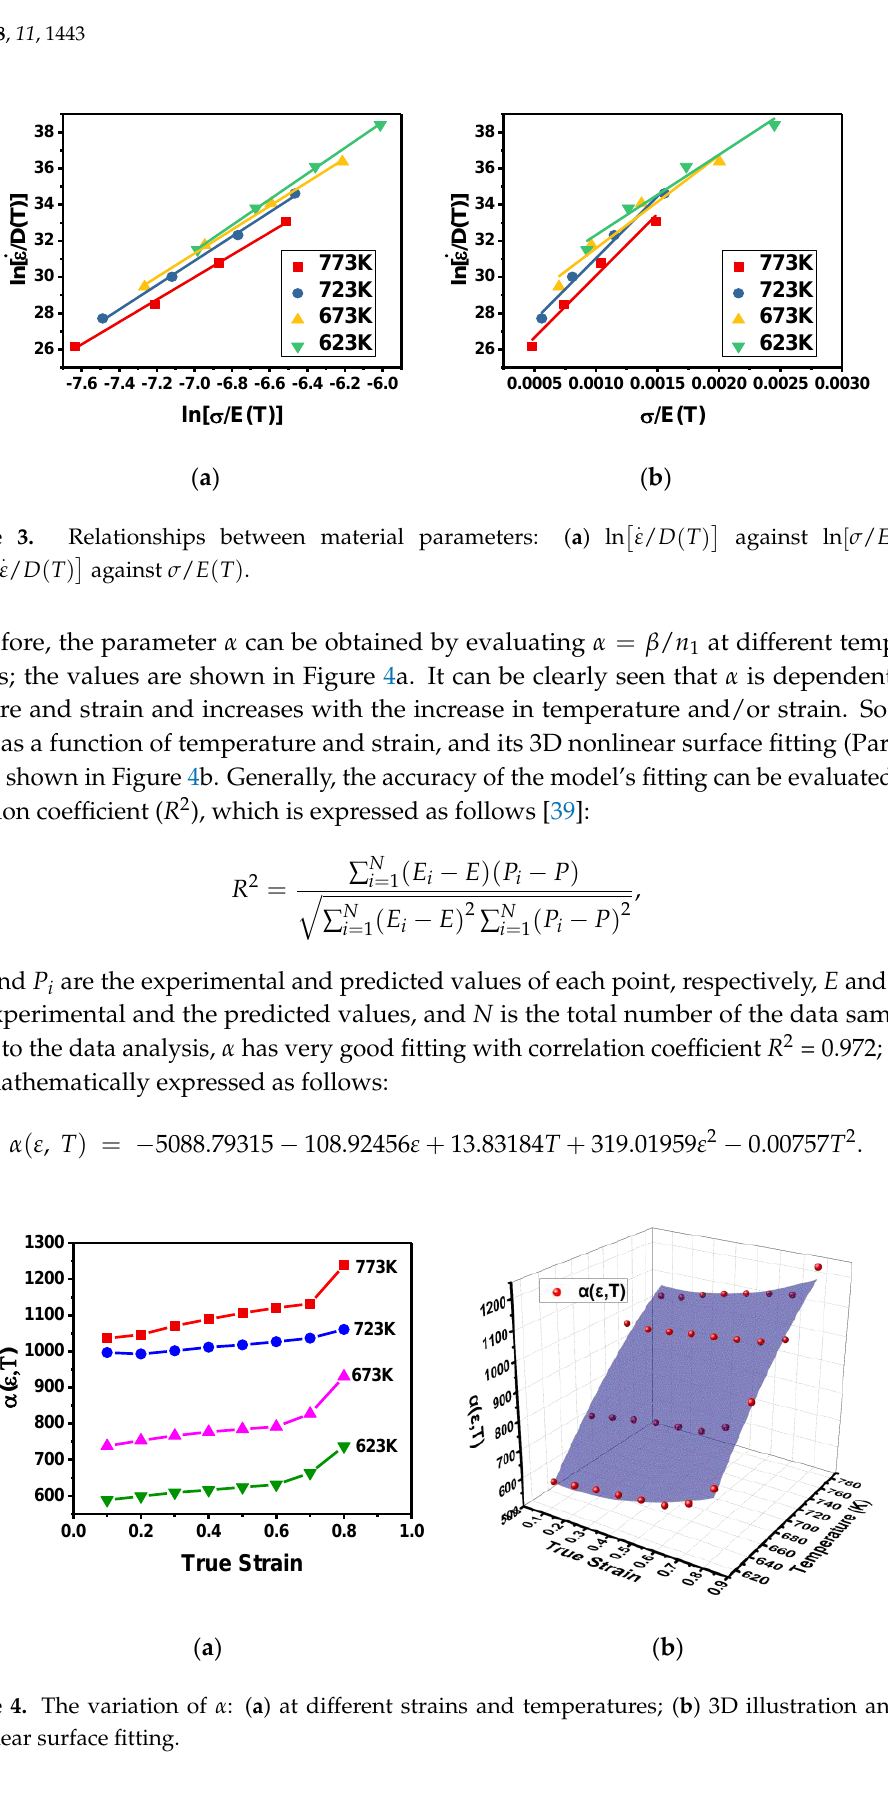
(cid:2) . (cid:3) ε / D ( T ) against ln [ σ / E ( T )] ;